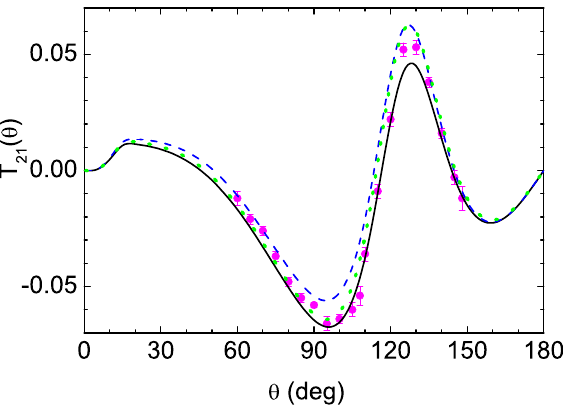
Fig. 1. Tensor analyzing power T 21 ( θ ) of the pd elastic scatter- ing at E p = 10.0 MeV (or equivalently E d = 20.0 MeV). The solid (black) curve denotes the calculation with AV18, the dashed (blue) curve that with AV18 + BR 660 , and the dotted (green) curve that with AV18 + BR 800 + V phe . Experimental data are taken from Ref.